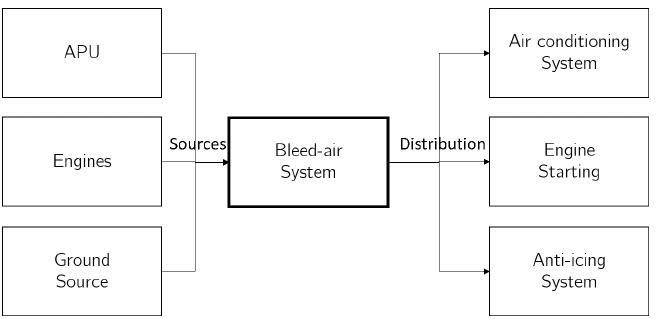
Figure 1. Sources and functions of bleed-air